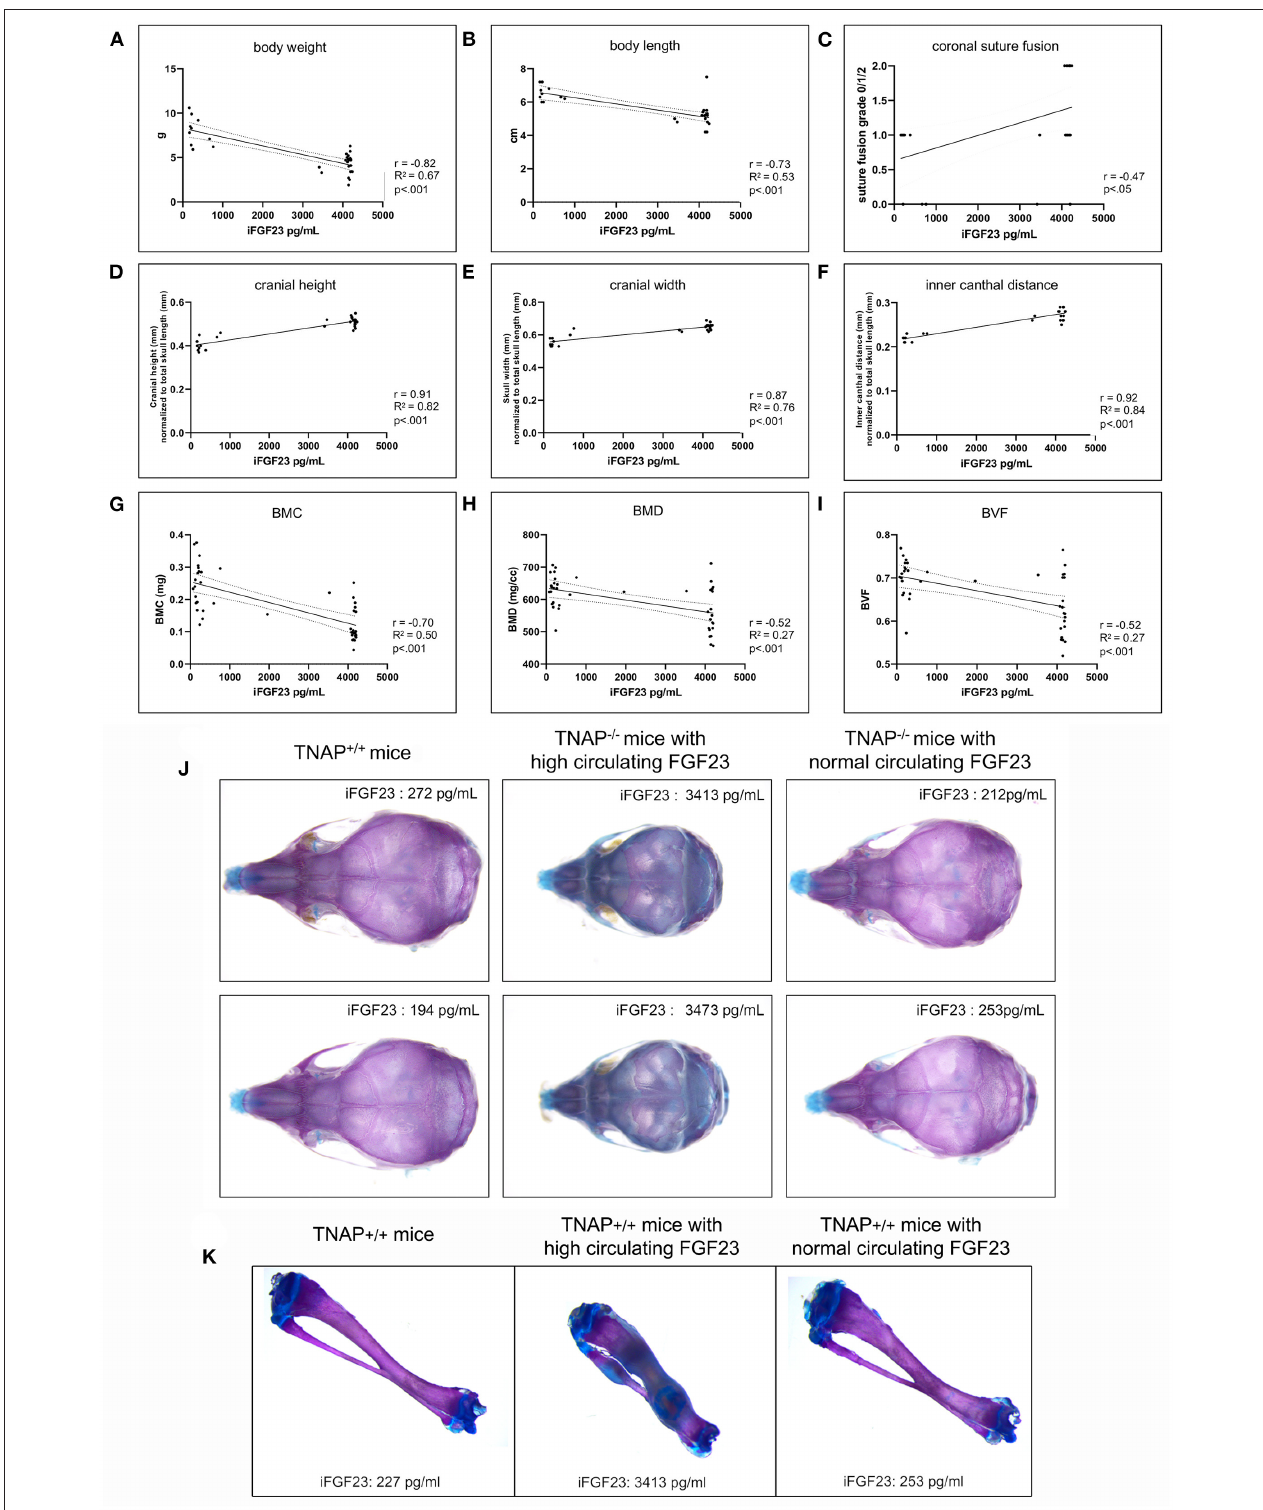
FIGURE 9 | Correlation of FGF23 serum levels with body and skull phenotypes. Body weight (A) , body length (B) , skull shape measurements (D–F) and cranial bone micro-CT measurements (G–I) were compared to serum FGF23 levels in TNAP − / − ENPP1 + / + mice using Pearson correlation coefficient ( r ) with coefficients